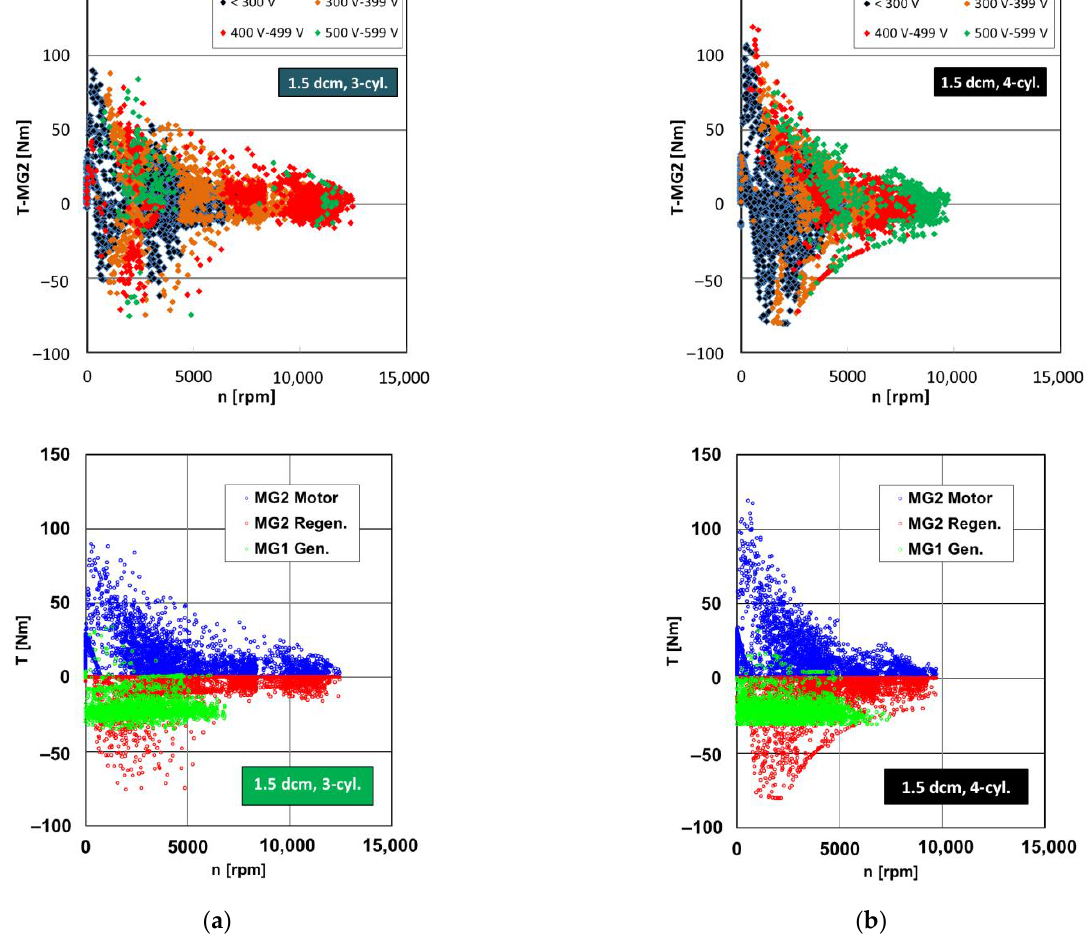
Figure 4. MG2 motor operating conditions: ( a ) the newer solution with the 3-cylinder engine; ( b ) the older solution with the 4-cylinder engine.